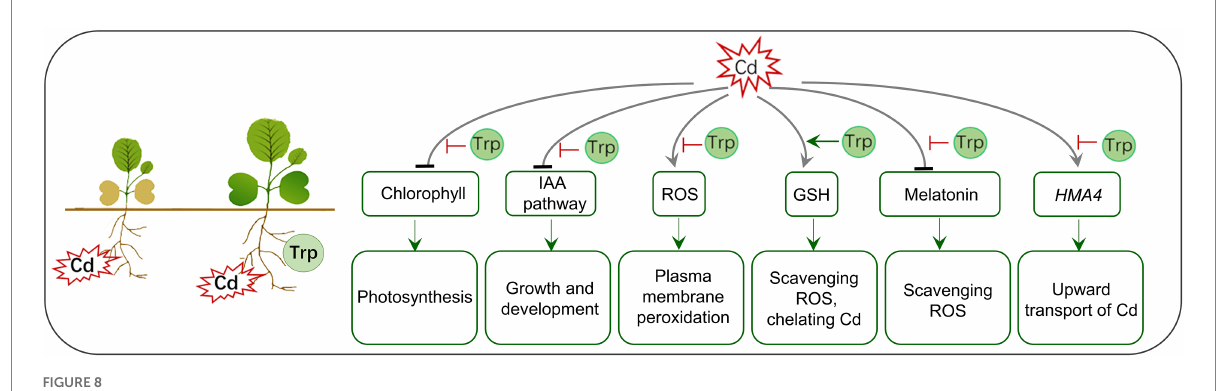
FIGURE 8 A hypothetical model for Trp application affecting toxicity and transport of